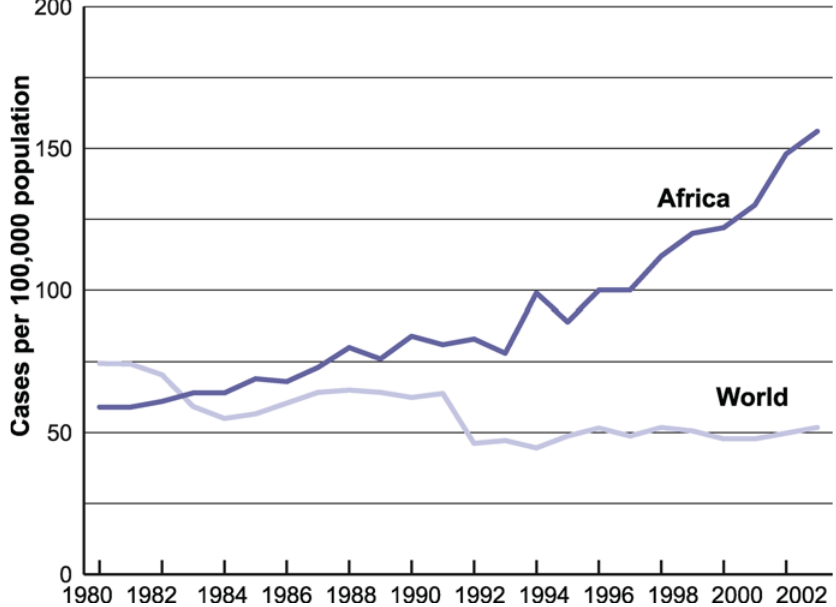
doi:10.1371/journal.pmed.0030455.g007 Figure 7. Tuberculosis Case Notifi cation Rates, 1980–2003 Figure derived from